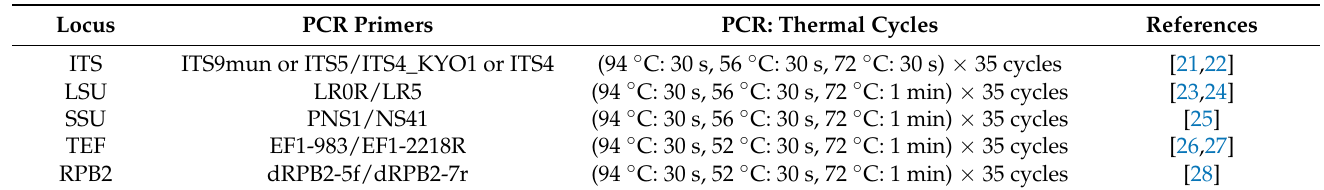
Table 1. Loci used in this study with the corresponding PCR primers and conditions.